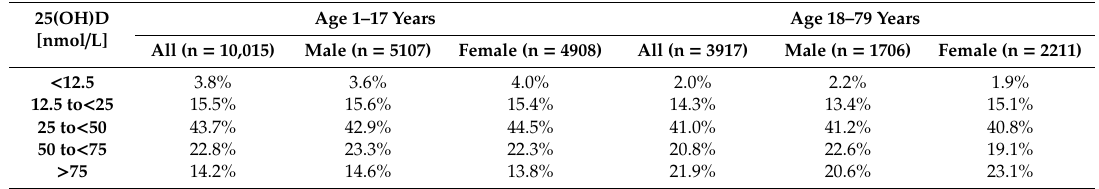
Table 1. Prevalence of 25(OH)D serum concentration in Germany, classified by age and sex (cited from reference